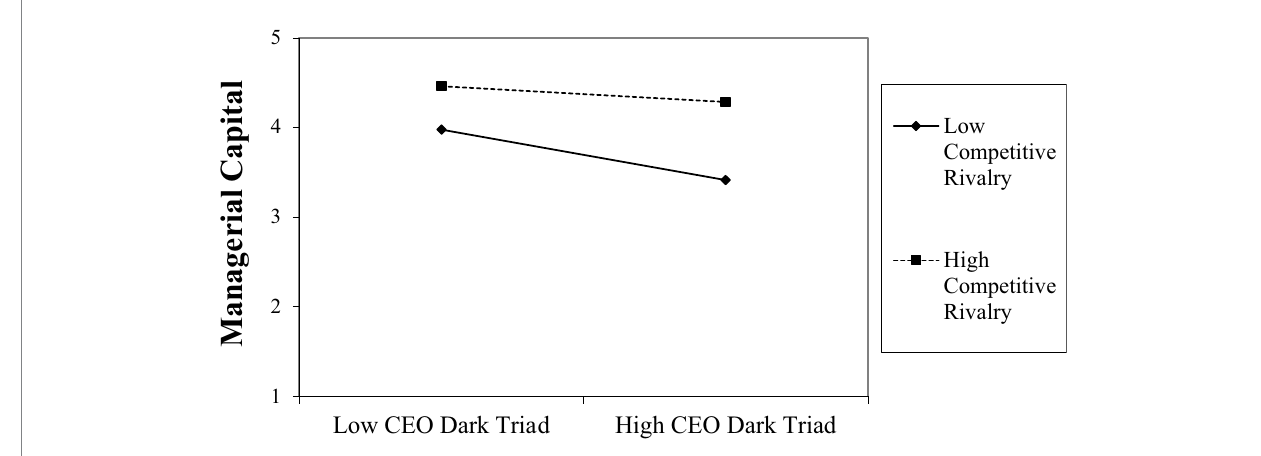
FIGURE 3 Interaction effects of competitive rivalry on CEO dark triad in terms of managerial